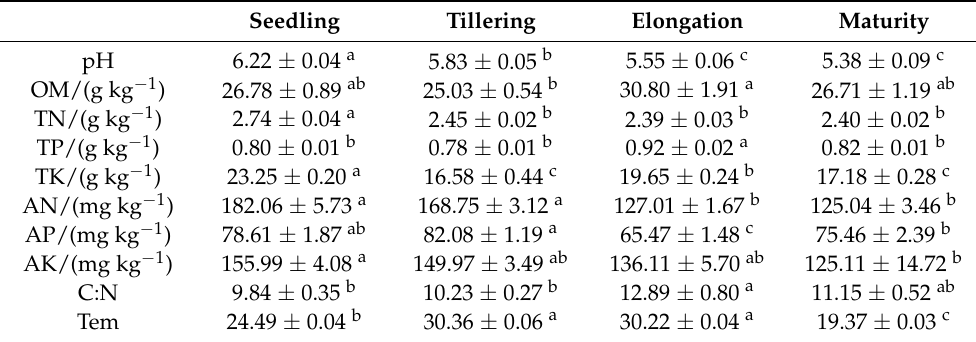
Table 2. Changes of soil nutrients in sugarcane at different growth